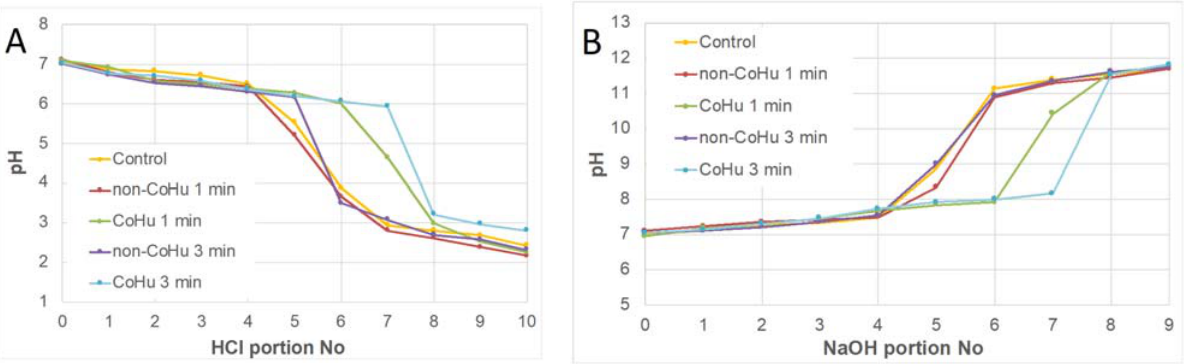
Figure 10. Typical curve of titration of 0.05 M phosphate buffer treated with CoHu or non-CoHu with 0.1 M HCl ( A ) and